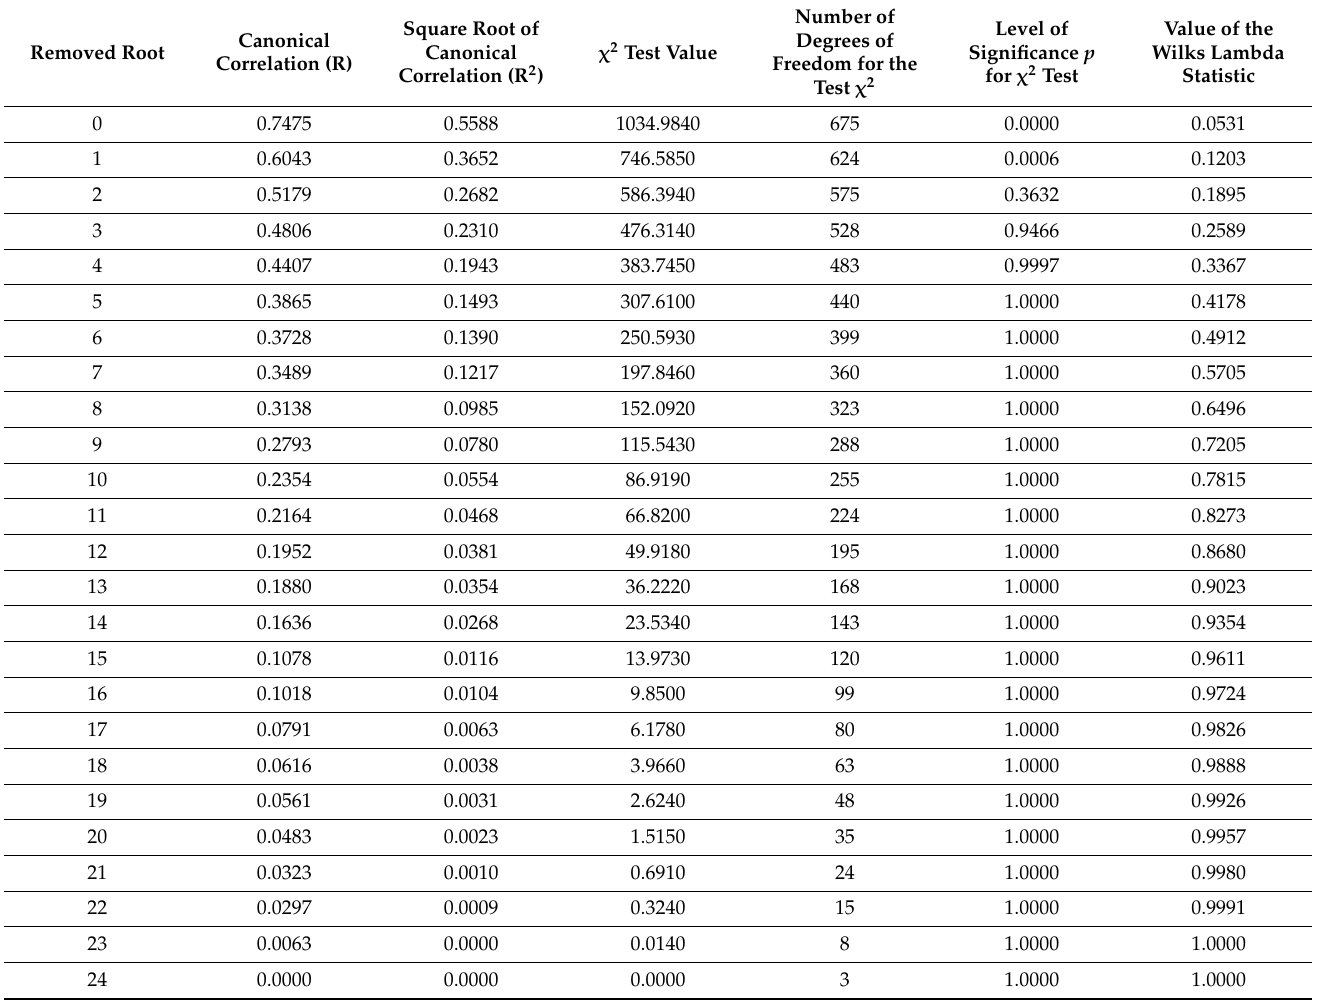
Table 4. Wilks lambda test